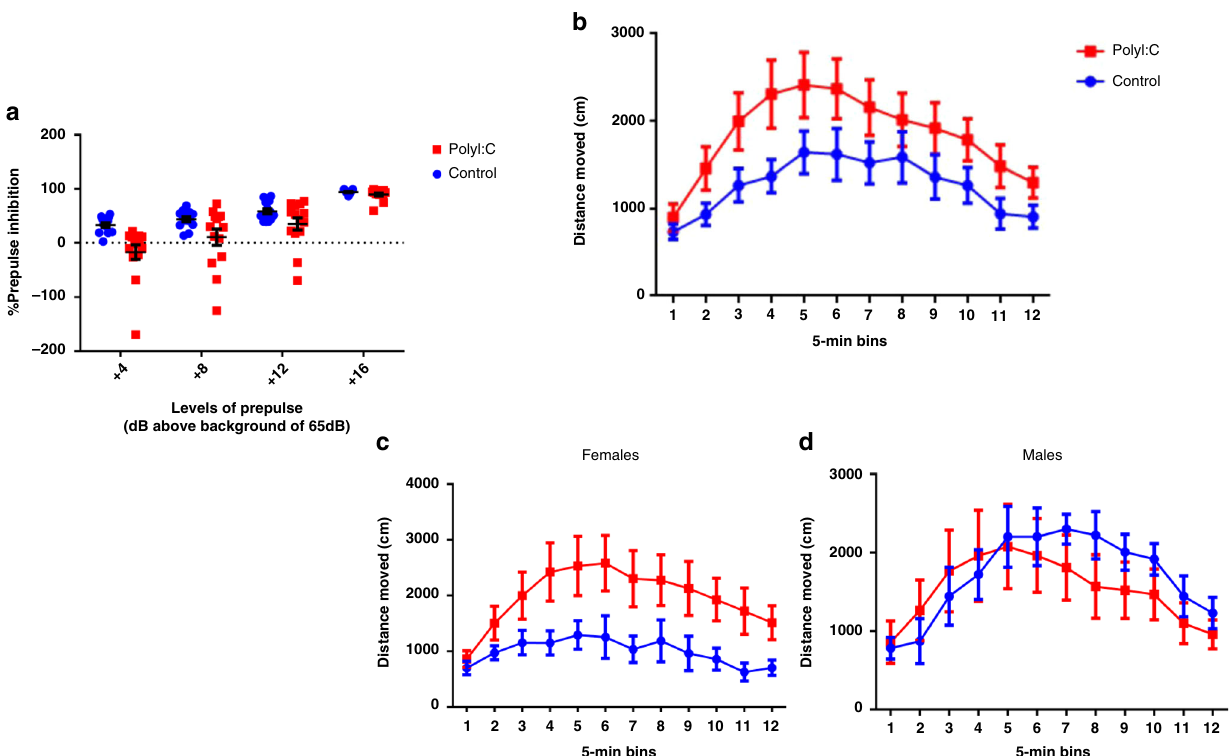
Fig. 1 Behavioral changes in the offspring of PolyI:C-treated mothers. a PPI data (mean ± SEM) shows the percent of prepulse inhibition of the startle response following the presentation of prepulse-plus-pulse acoustic stimuli. PolyI:C offspring showed a signi fi cant PPI de fi ciency ( n = 13 Control and n = 14 for PolyI:C, two-sided p value = 0.002; obtained from F test with (2,26) degrees of freedom) compared to controls at four different prepulse intensities (69, 73, 77, and 81 dB), regardless of gender. b Locomotor activity measured following an initial 30-min habituation period, a 30-min period following an injection of saline, and a 1-h period following a challenge injection of 2.5 mg/kg amphetamine (data only shown for last segment). PolyI:C mice displayed enhanced locomotor activity compared to control mice ( n = 13 for Control and n = 14 for PolyI:C, two-sided p value = 0.02; obtained from F test with (1,26) degrees of freedom), and the effect was stronger in females than in males ( c females: n = 8 for Control, n = 7 for PolyI:C, two-sided p value = 0.03; obtained from F test with (1,13) degrees of freedom; d males: n = 5 for Control, n = 7 for PolyI:C, two-sided p value = 0.74; obtained from F test with (1,11) degrees of freedom). All values are means ± SEM. Source data are provided as a Source Data fi